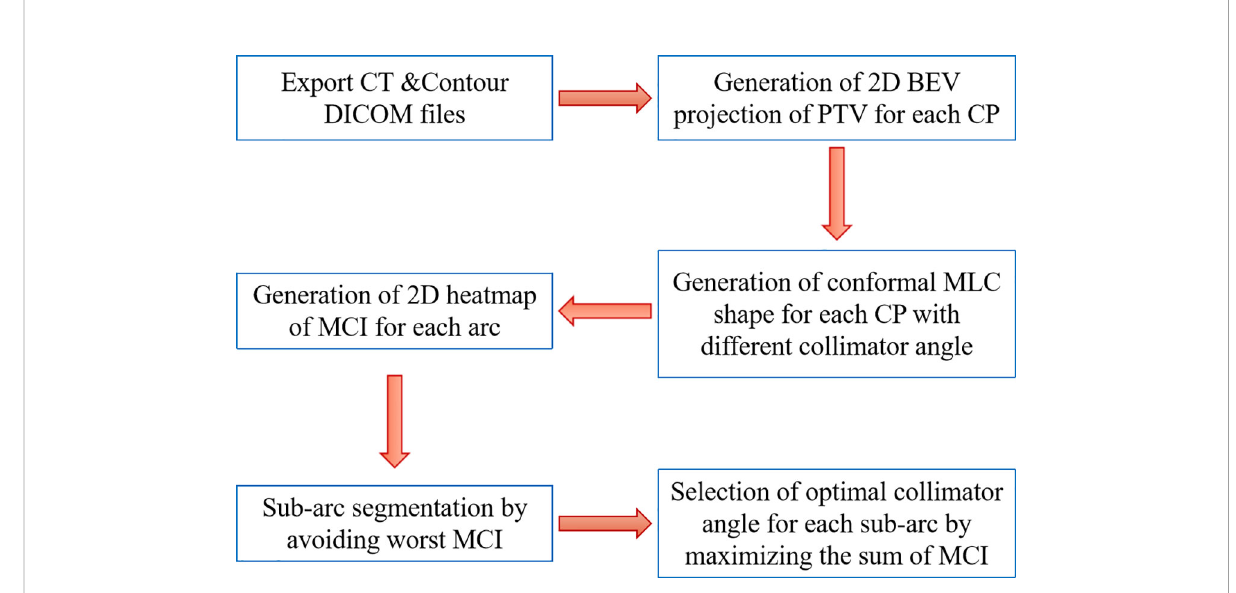
FIGURE 2 Flowchart of sub-arc collimator angle optimization (SACAO).